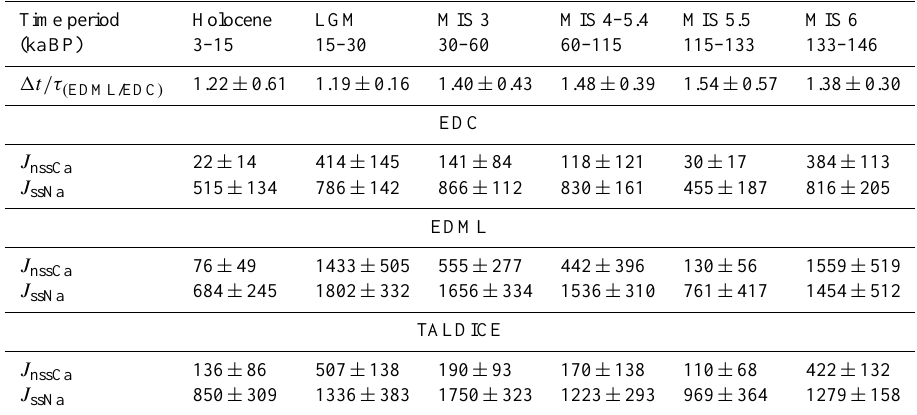
Table 2. Transport model results and ice core averages. In the first row the 1t/τ values of EDML vs. EDC for different time periods during the past 150ka are shown. Below, the fluxes of nssCa 2 + ( J nssCa ) and ssNa + ( J ssNa ) are indicated for EDC, EDML, and TALDICE, for the corresponding time intervals (given in µgm − 2 a − 1